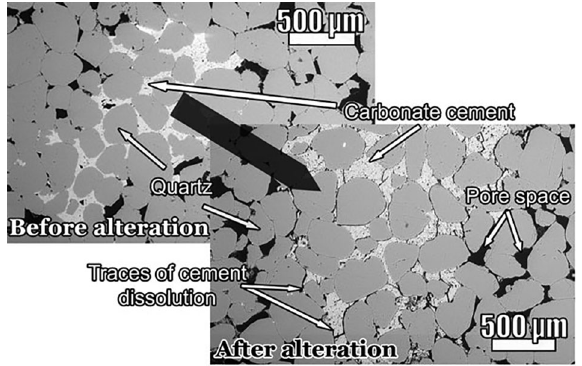
Fig. 7. SEM microphotographs of thin sections of trans- reservoir carbonate-cemented medium-grained poorly sorted Deimena sandstone sample Kn24-4 (Table 4) before (left) and after (right) the alteration experiment. The composition is oligomictic, predominantly characterized by subrounded quartz grains. XRD analyses revealed very minor presence of ankerite (Ca(Fe,Mg,Mn)(CO 3 ) 2 ) minerals. The light-coloured area is pore filling ankerite cement, occupying more than 50% of pores in the thin section. The presence of about 5% clay-supported matrix was determined before the alteration experiment. Clay-supported matrix is locally blocking interparticle porous media (left). The porosity has very thin intermediate channels responsible for very low permeability before alteration. Visual analysis of thin sections confirmed the measured porosity (5–10% by Shvetsov 1948, Table 4). Traces of the dissolution and microfracturing of carbonate cement on the edges of grains and inside the pore filling and displacement of the clay-supported matrix blocking pores after the experiment were determined (right). This pheno- menon explains drastically increased permeability measured after alteration (Table 4). Sample Kn24-4 was of ‘very low’ reservoir quality before the alteration experiment and became of ‘moderate’ reservoir quality (class IV) after the experiment.